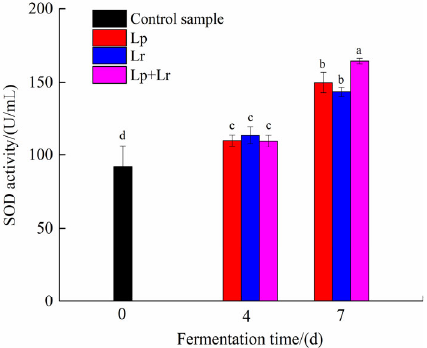
Figure 6. SOD activity of edible grass during fermentation. Different superscript letters in the columns indicate significant difference ( p < 0.05). Abbreviations: Lp, Lactobacillus plantarum ; Lr, Lactobacillus rhamnosus ; Lp+Lr, mixture of Lactobacillus plantarum and Lactobacillus rhamnosus